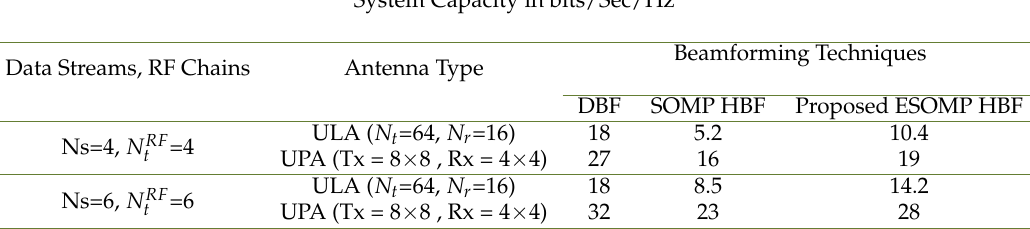
Table 1. Performance comparison in terms of system